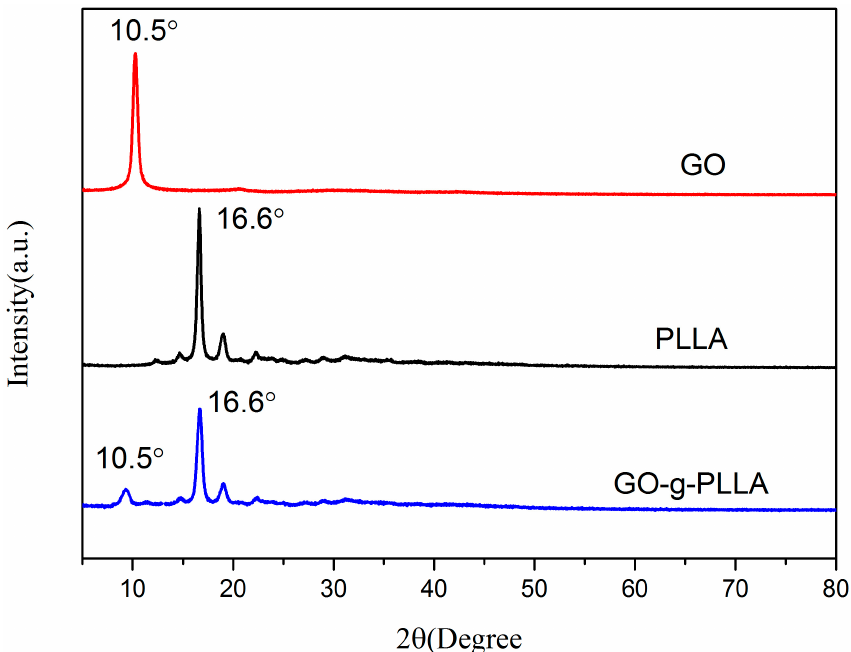
Figure 2. The XRD patterns of pure GO , PLLA, and GO- g -PLLA.